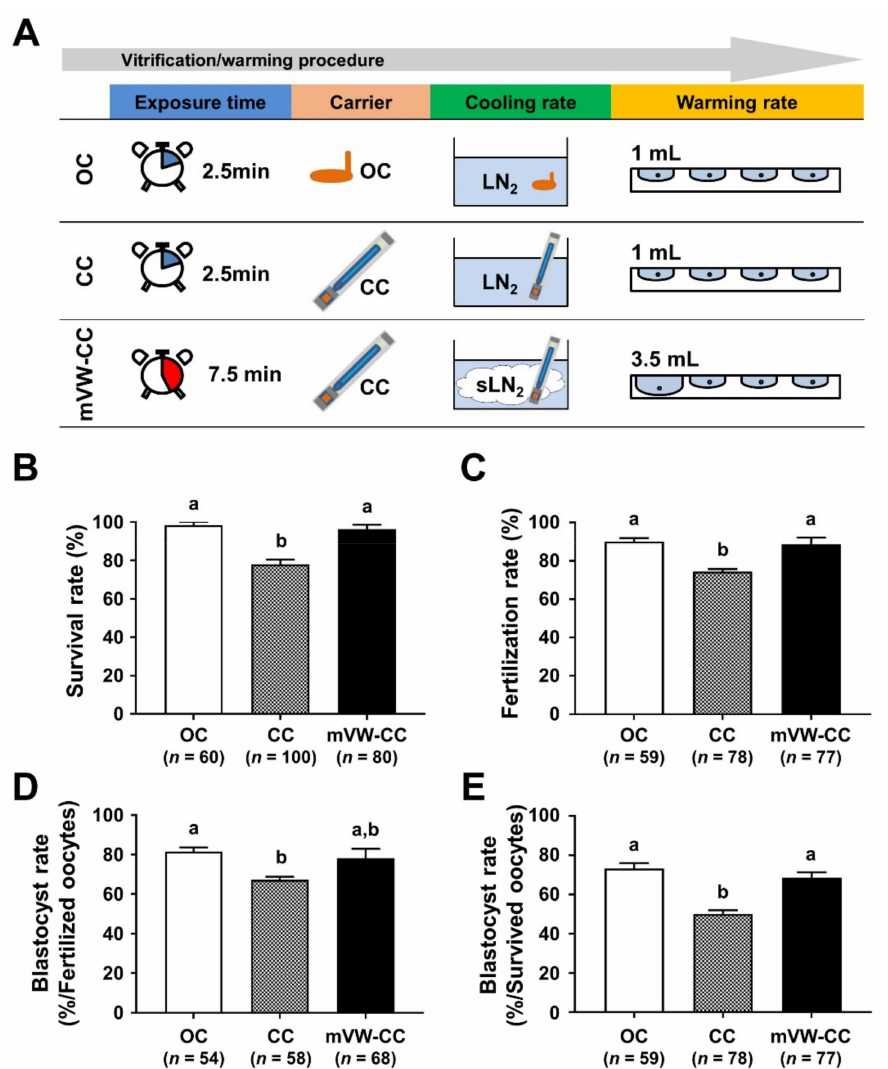
Figure 6. Comparative analyses of the survival and development rates of oocytes vitrified/warmed (VW) using open carrier system (OC), closed carrier system (CC), and modified vitrification/warming CC system (mVW-CC). Comparison of the procedure ( A ), survival ( B ), fertilization ( C ), and blastocyst formation rates ( D , E ) of VW oocytes using different carrier systems. Blastocyst formation rates (the number of blastocysts/the number of fertilized oocytes ( D ) and/the number of survived oocytes ( E )). Different superscript letters (a,b) indicate p < 0.05. The number of experiments = 3 (18–35 oocytes per group in each